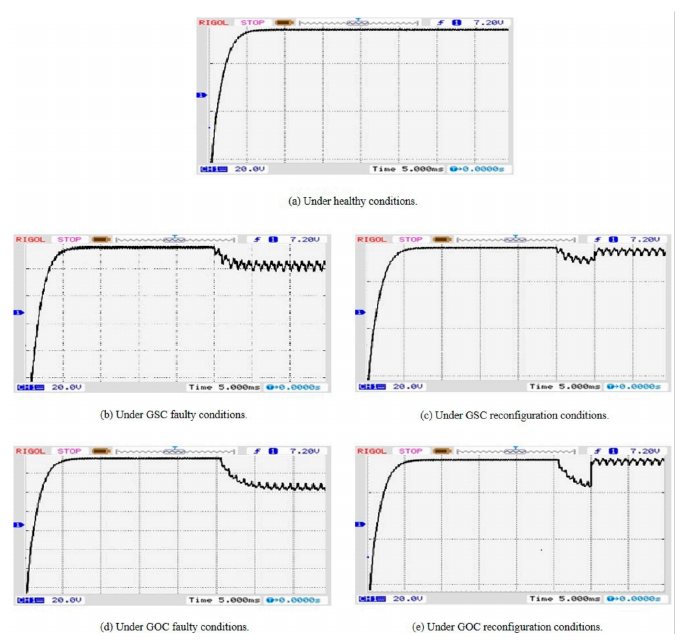
Figure 13. Rotor speed of the induction motor for healthy conditions, and faulty and reconfigura- tion